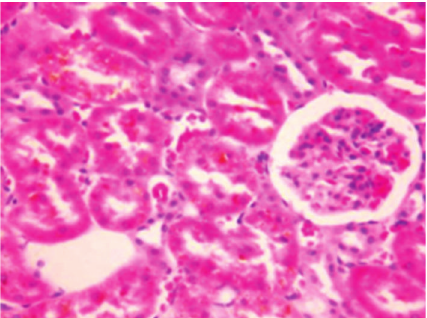
Figure 7: Sham-operated group 28 days; normal lung tissue; HE ×